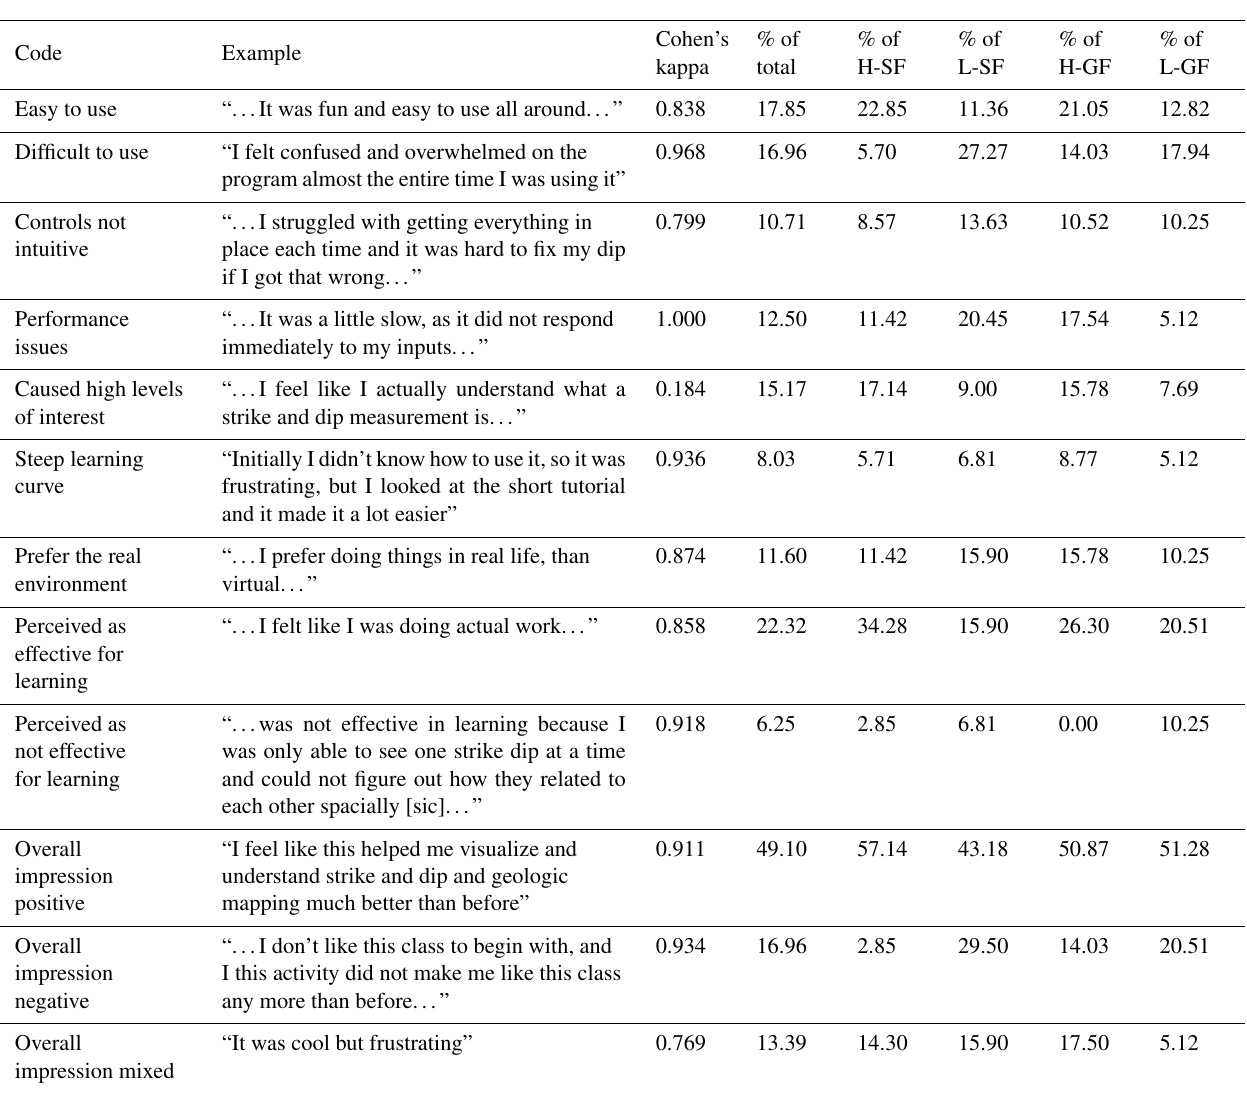
Table 6. Qualitative analysis results for the open-ended learning experience